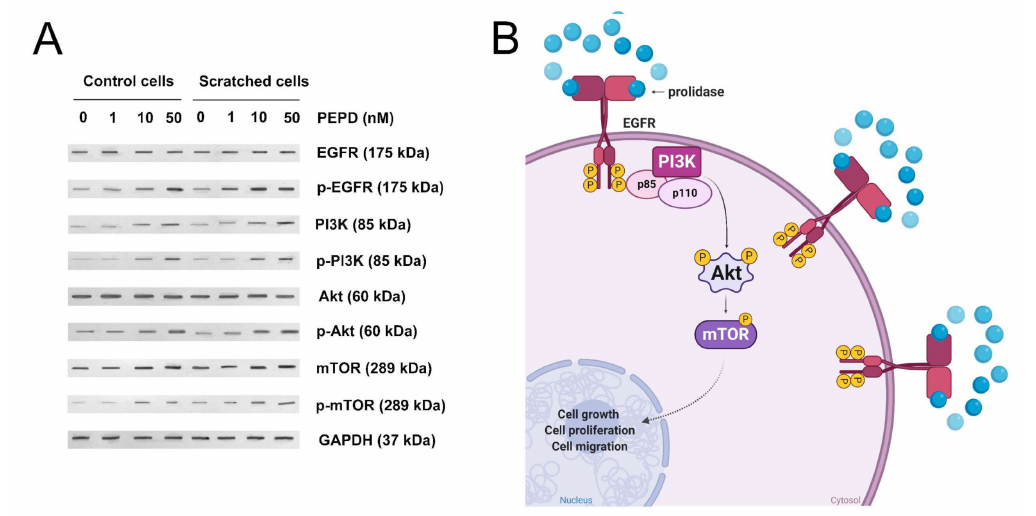
Figure 4. Prolidase induces EGFR-downstream signaling pathway. ( A ) The proteins of the EGFR-downstream signaling pathway analyzed by Western immunoblotting in lysates of control and scratched prolidase-stimulated HaCaT cells. GAPDH was used as a loading control. Representative blot images are shown (densitometric analysis of presented protein is included in Supplementary Materials (Supplementary Figure S3)). ( B ) An illustration of the prolidase-dependent EGFR-downstream signaling pathway activation. Created with